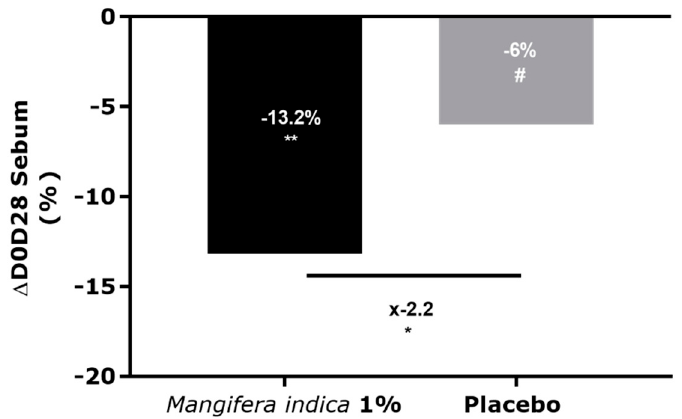
Figure 5. Sebum analysis by Sebumeter ® on Caucasian volunteers after 28 days of application of cream containing M. indica extract at 1% or placebo. Significance with # p < 0.1, * p < 0.05 and ** p < 0.01.